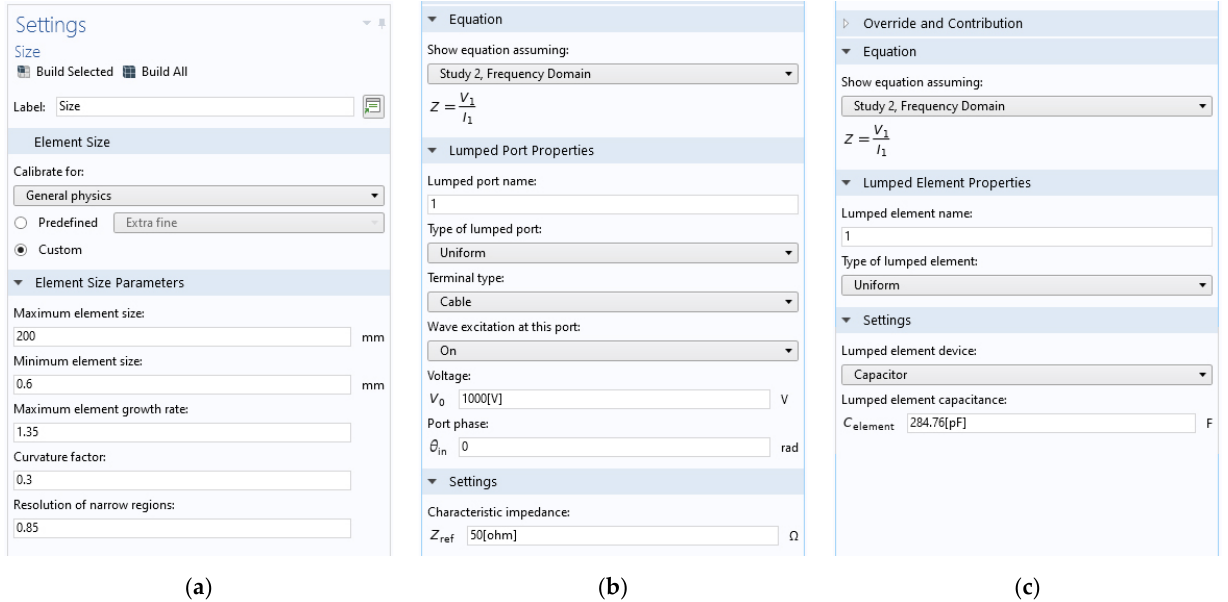
Figure 2. Configuring COMSOL interfaces: ( a ) Mesh; ( b ) lumped port; ( c ) lumped element.